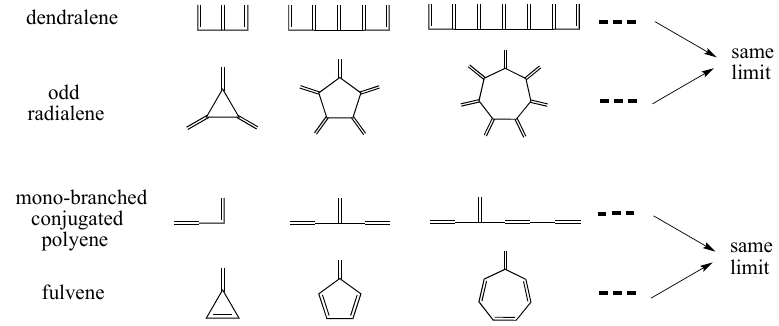
Figure 13. Infinitely large odd radialenes and fulvenes, respectively, converge to the limit of certain cross-conjugated acyclic polyenes.